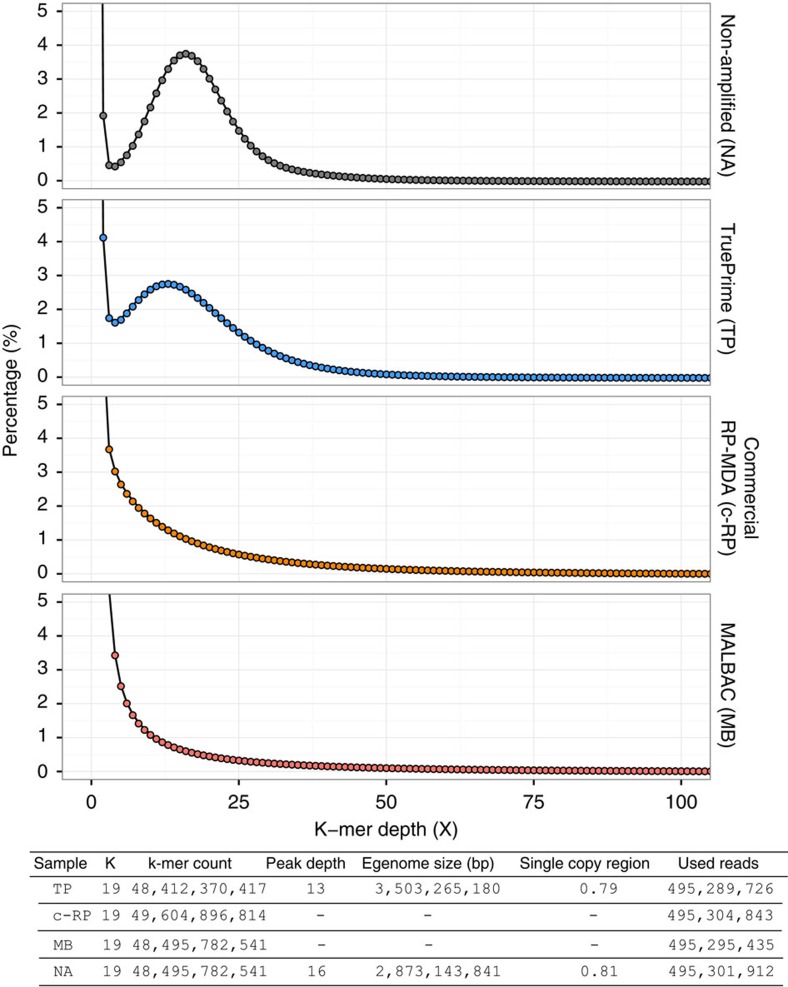
K-mer comparisonK-mers were calculated with jellyfish. The x axis shows the k-mer bin size, the y axis shows the frequency of the corresponding k-mer bin in per cent. The NA sample and TruePrime show a clear separation of signal k-mer from error noise at low bin sizes, the commercial RP-MDA kit and MALBAC display no such separation. The estimated genome sizes E were calculated on the basis of the k-mer distribution as , where B is the bin size, F is the corresponding frequency and P is the peak depth estimated from the k-mer distribution. Only k-mer bins with size >4 were included, as lower bin sizes tend to be random noise originating from the library construction and sequencing process. Single-copy region contains the amount of k-mers covering the single copy peak from bin size 4 to bin size 50.